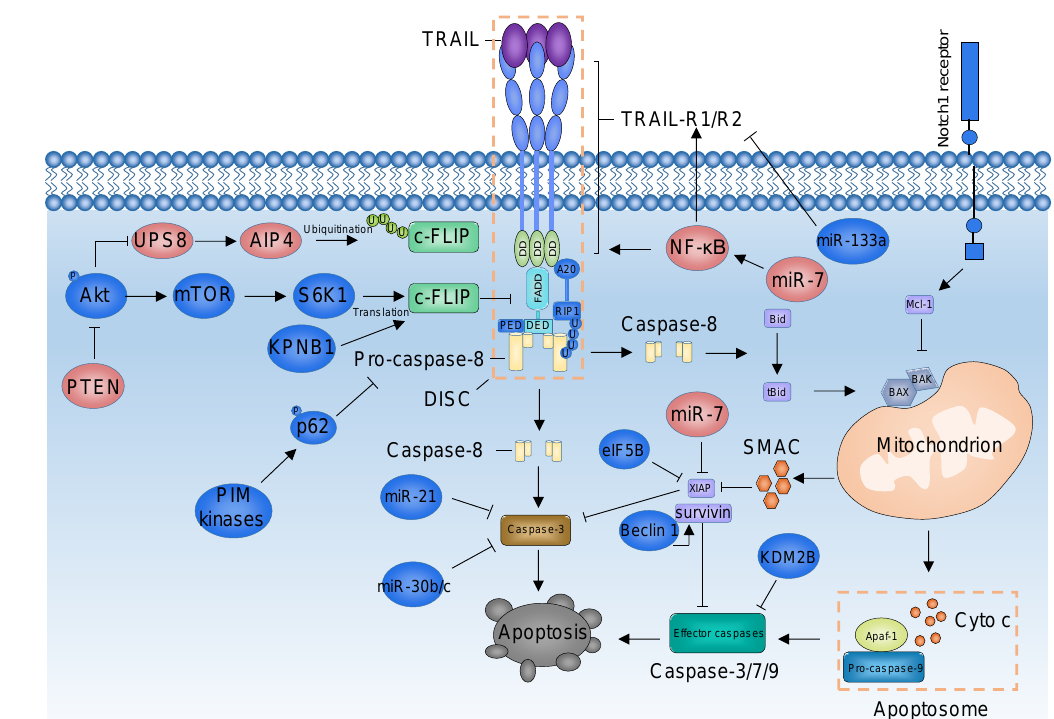
Figure 1. Updated mechanisms that regulate TRAIL-induced apoptotic signaling in glioblastoma multiforme (GBM). Proteins depicted in deep blue are negative regulators of TRAIL-induced apoptosis, whereas proteins depicted in pink are positive regulators of TRAIL-induced apoptosis in GBM. TRAIL, tumor necrosis factor-related apoptosis-inducing ligand; TRAIL-R1/R2, TRAIL receptor1/recptor2; DD, death domain; FADD, FAS-associated death domain protein; DED, death effector domain; PED, phosphoprotein enriched in diabetes; c-FLIP, cellular FLICE inhibitory protein; DISC, death-inducing signaling complex; RIP1, receptor interacting protein kinase 1; A20, E3 ubiquitin ligase A20/TNFAIP3; AIP4, atrophin- interacting protein 4; PIM, proviral integration site in Moloney murine leukemia virus; NF-κB, nuclear factor-κB; SMAC, second mitochondria-derived activator of caspase; Apaf-1, apoptotic peptidase activating factor 1; KDM2B, lysine-specific demethylase 2B; Cyto c, cytochrome c.